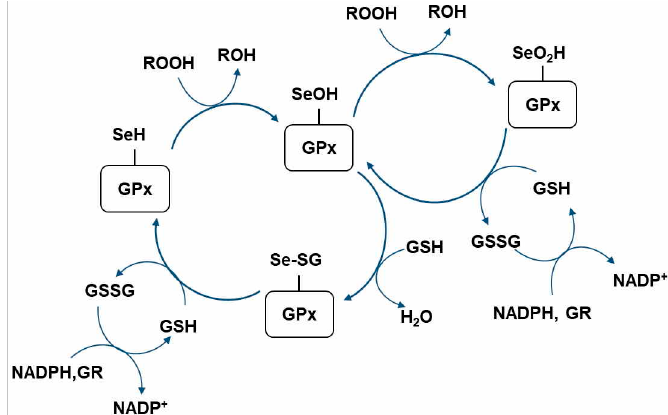
Figure 1. Catalytic redox cycle of glutathione peroxidase. GR, glutathione reductase; GSH, glutathione (reduced form); GSSG, glutathione disulfide; GPx-SeOH, selenenic acid; GPx-SeSG, selenenyl sulfide; GPx-SeO 2 H, seleninic acid; ROOH, hydroperoxides (H 2 O 2 , peroxynitrite or aliphatic hydroperoxide); ROH, H 2 O or corresponding alcohol; NADPH, Nicotinamide adenine dinucleotide